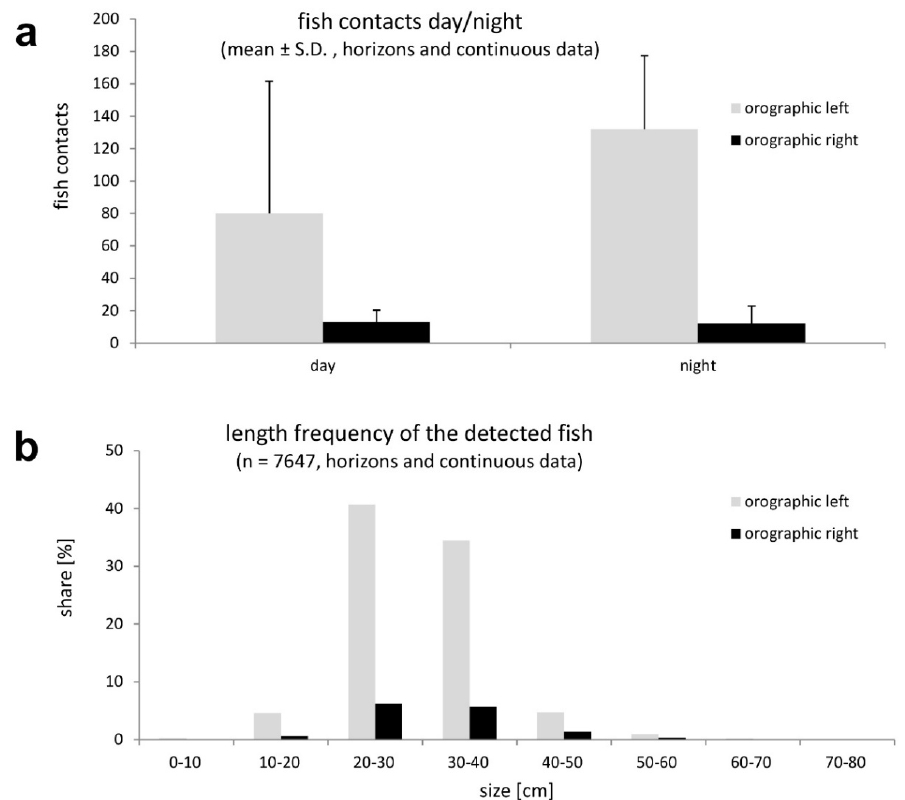
Figure 8. ( a ) Day versus night comparison (in early April sunrise = 06:45, sunset = 19:50; according to www.zamg.at) of the number of fish contacts h − 1 and ( b ) the length frequency of the detected fish (based on the evaluated data sets of 49 h sonar data from the period 4–8 April 2017).